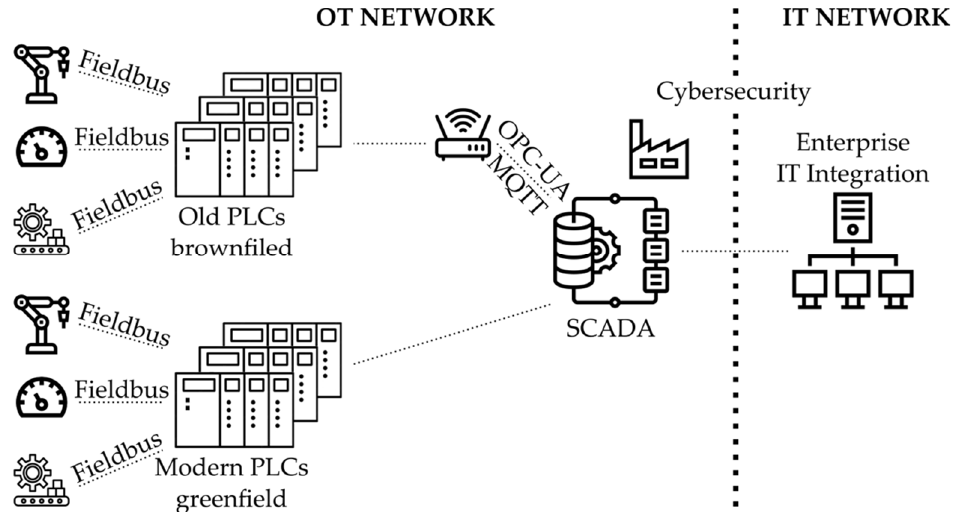
Figure 2. Data collection from operational technology (OT) to information technology IT networks.